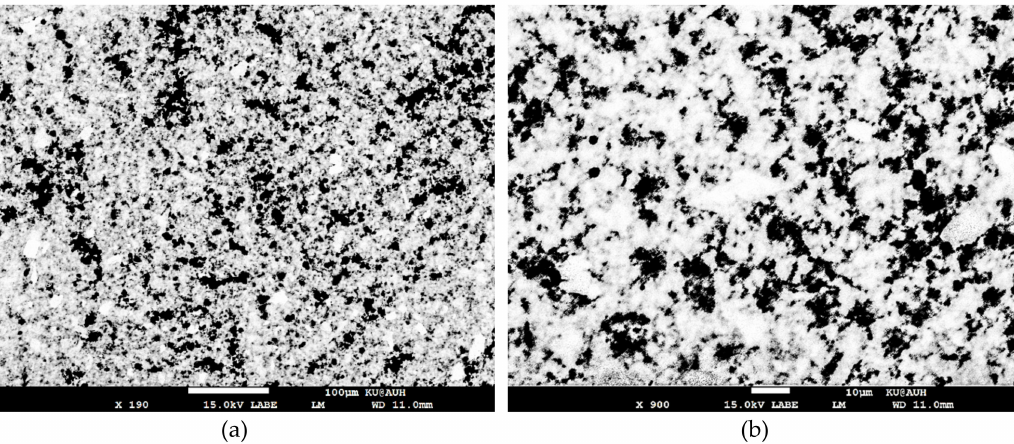
Figure 4. SEM images at di ff erent magnifications of 800 nm thickness porous gold film fabricated with 4 mg / mL GO and etched for 60 s. ( a ) × 190 magnification; ( b ) × 900